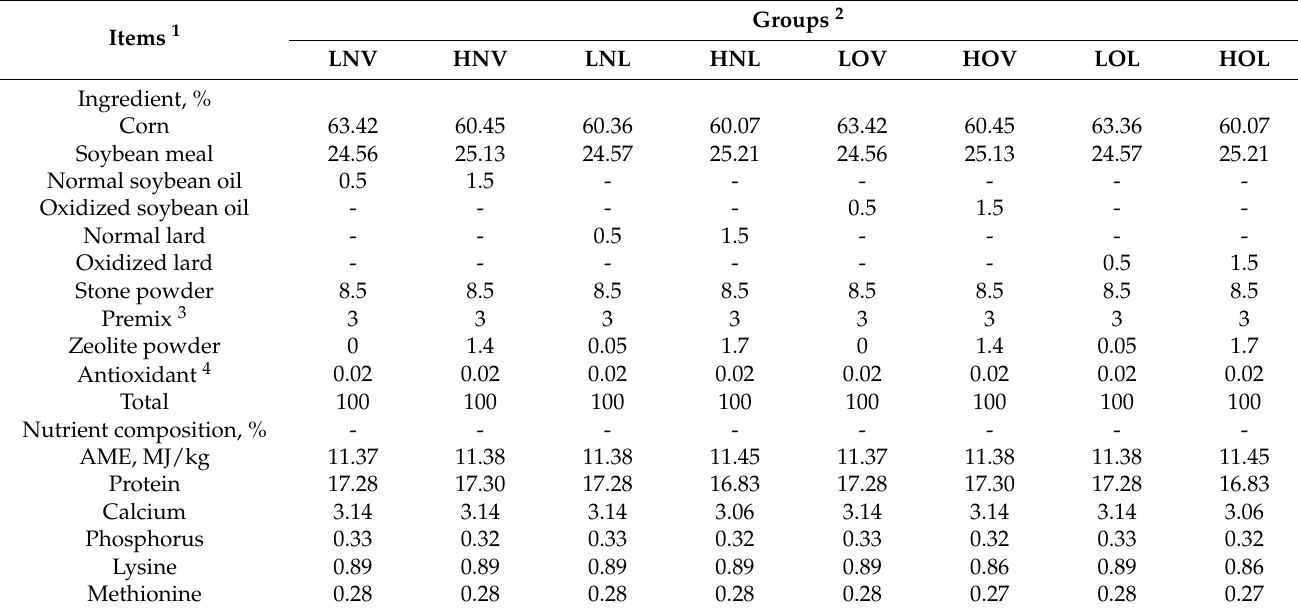
Table 1. Composition of laying hens’ diets.